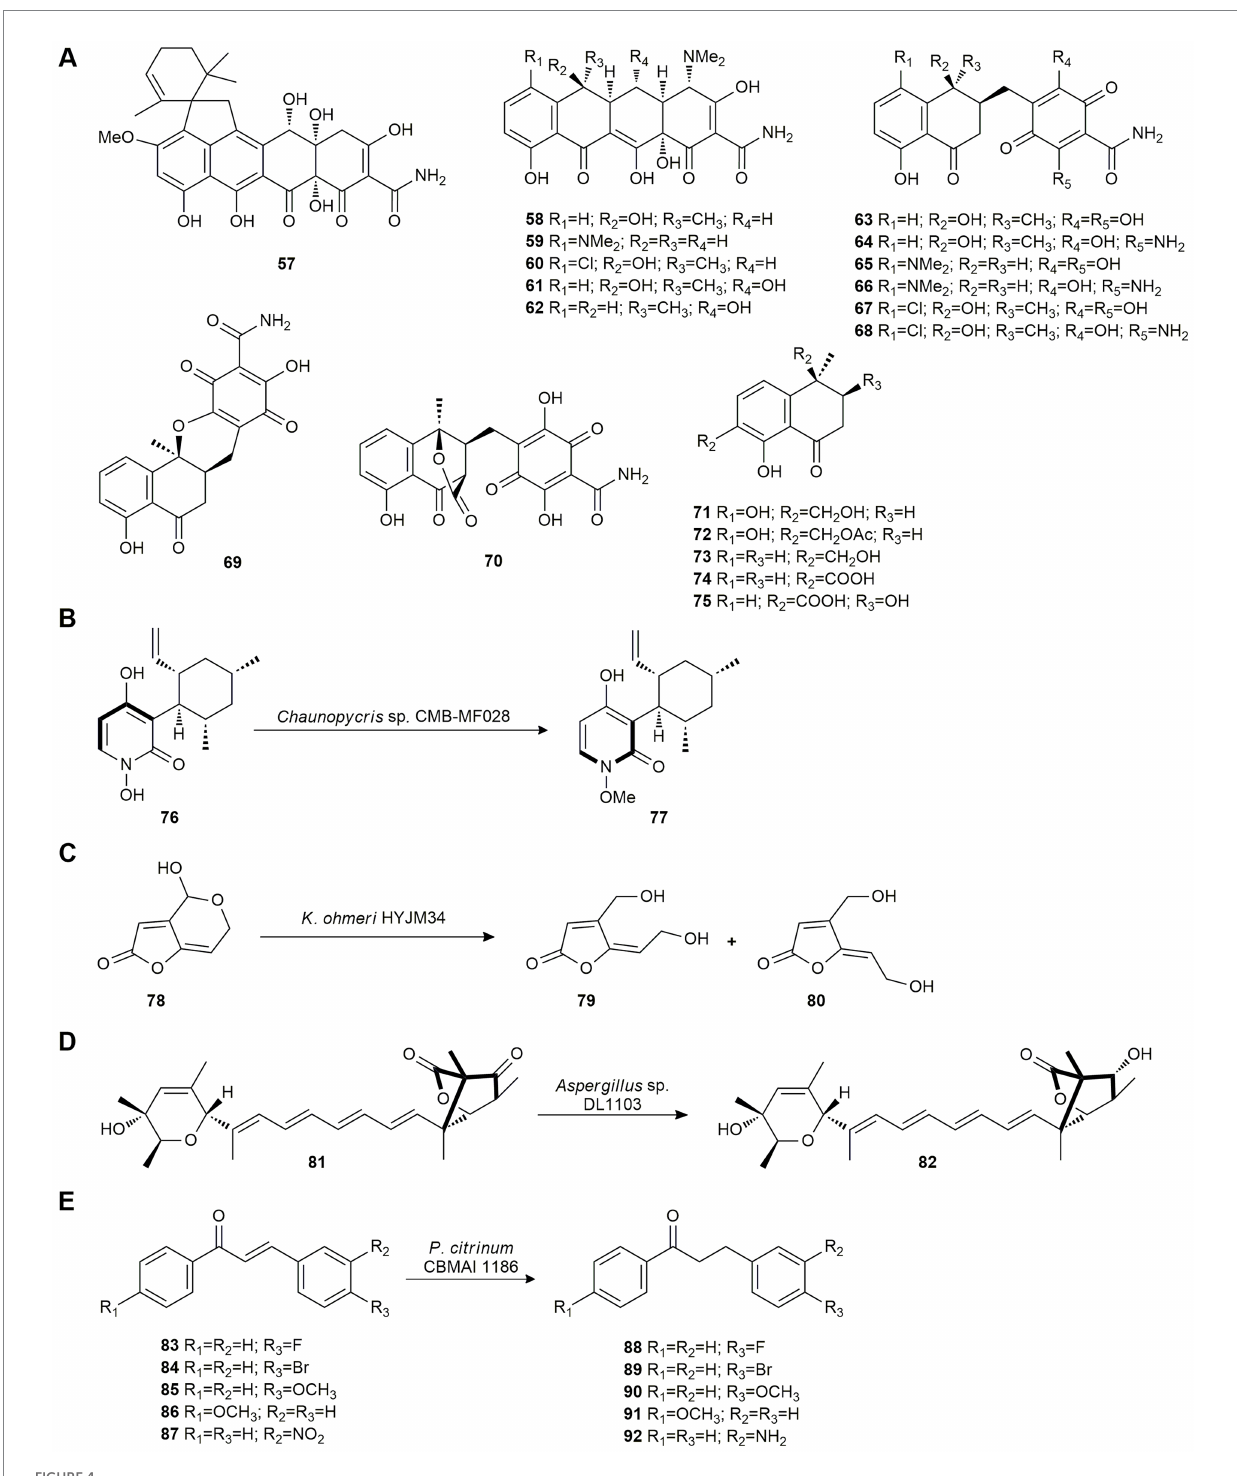
FIGURE 4 Polyketide biotransformations. (A) Production of seco -cyclines ( 63–70 ) from tetracycline ( 58 ), minocycline ( 59 ), chlortetracycline ( 60 ), and hemi - cyclines ( 71–75 ) from oxytetracycline ( 61 ) and doxycycline ( 62 ) by Paecilomyces sp. CMB-MF010 (Shang et al., 2016). (B) Biotransformation of pyridoxatin ( 76 ) 77 by Chaunopycris sp. CMB-MF028 (Shang et al., 2017). (C) Patulin ( 78 ) bioconversion by Kodameae ohmeri HY JM34 (Dong et al., 2015). (D) Reduction of wortmannilactone F ( 81 ) by Aspergillus sp. DL1103 (Liu et al., 2018d). (E) Reduction of chalcones 83–87 by Penicillium citrinum CBMAI 1186 (Ferreira et al.,